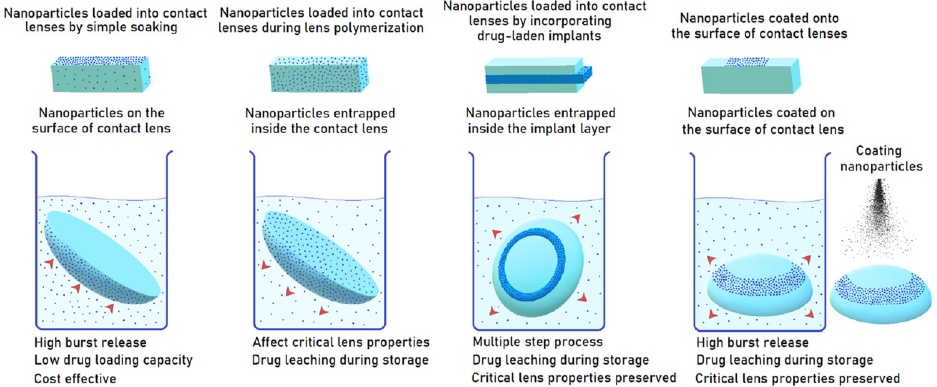
Figure 2. Four methods for manufacturing nanomaterial-loaded CLs. Reprinted with permission from Ref. [61] Advances and challenges in the nanoparticles-laden contact lenses for ocular drug delivery 2023, Elsevier. Table 1. Ocular studies with drug/nanoparticle incorporated in contact lenses.